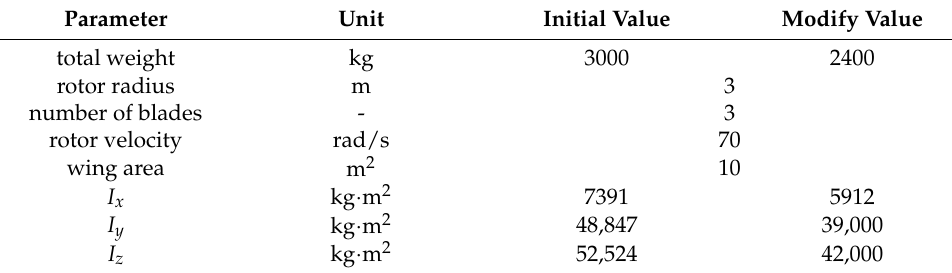
Figure 6. Schematic diagram of the tilt ‐ rotor UAV. Table 4. Parameters of the tilt ‐ rotor UAV.